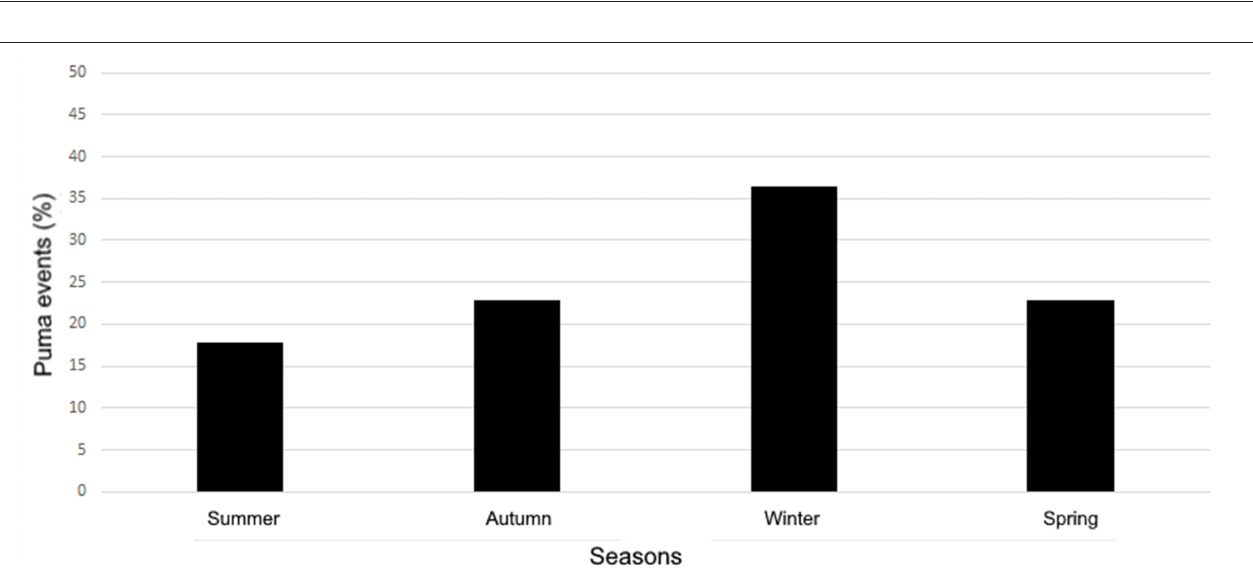
FIGURE 3 | Percentage of puma events, per season, in the Southern Hemisphere.